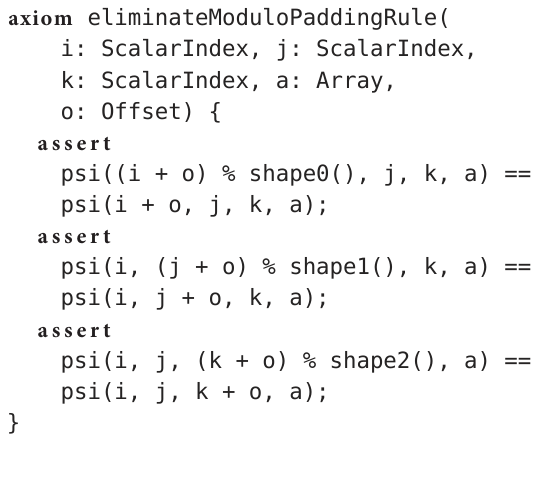
Table 2 Execution time (in seconds) of the three-dimensional PDE solver Magnolia implementation compiled to C ++ with specialized indexing and with or without